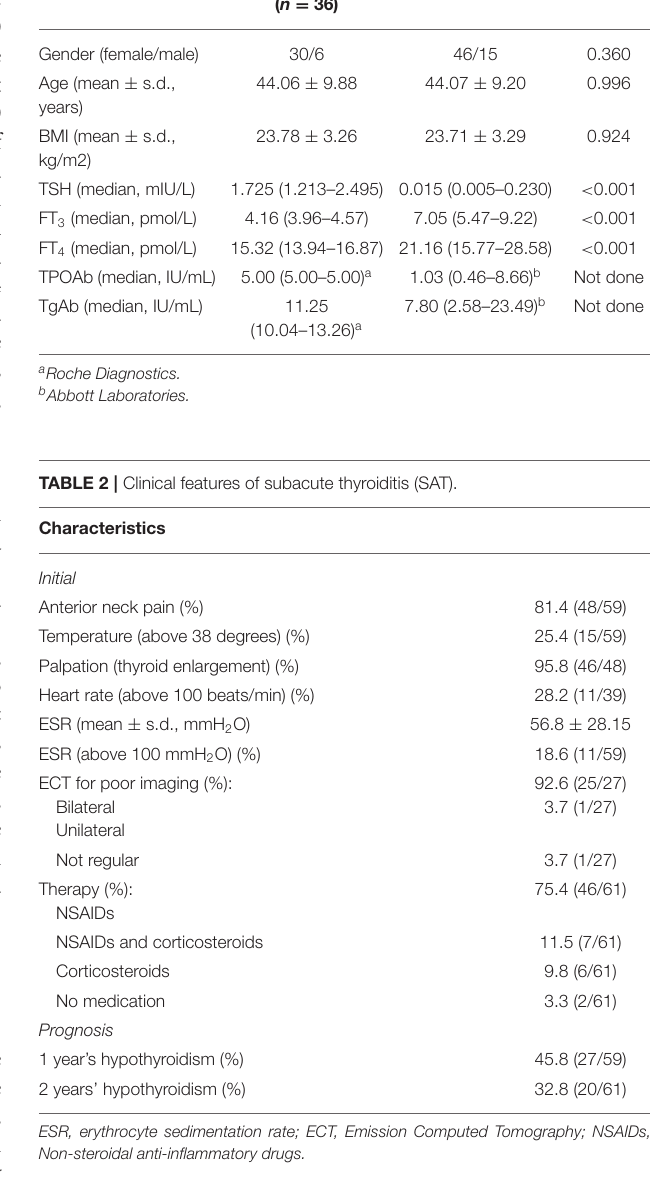
TABLE 1 | Clinical and demographic characteristics of patients with subacute thyroiditis (SAT) and healthy controls. Characteristics